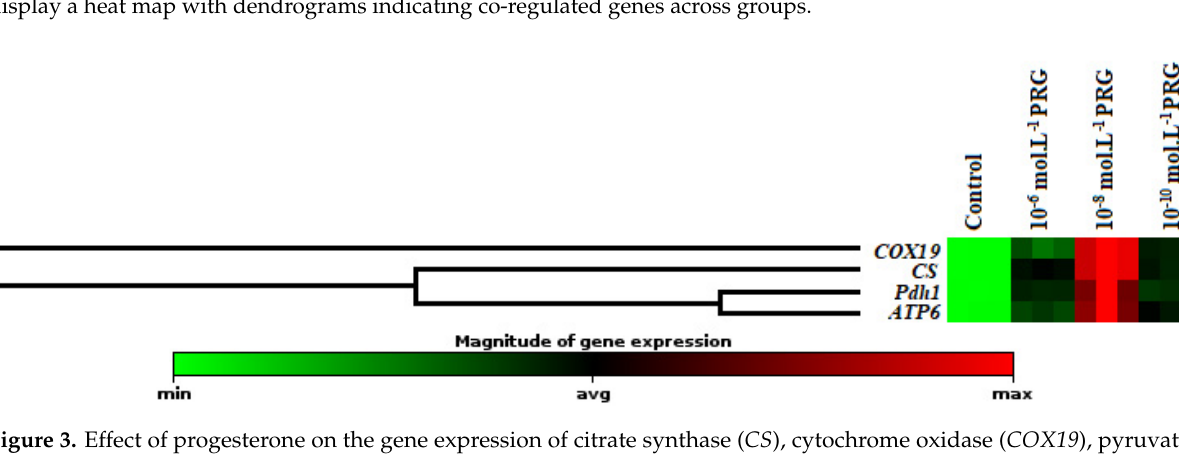
Figure 4. Effect of progesterone on the gene expression of citrate synthase ( CS ), cytochrome oxidase ( COX19 ), pyruvate dehydrogenase ( Pdh1 ), and ATP synthase ( ATP6 ) in the roots of 4-day-old maize seedlings. The clustergram performs non-supervised hierarchical clustering of the entire dataset to display a heat map with dendrograms indicating co-regu- lated genes across groups. 3. Discussion The present investigation aimed, for the first time, to reveal the effects of exogenous progesterone application on early seedling growth based on the changes in particularly mitochondrial respiration besides physiological ad biochemical parameters in germinat- ing maize seeds. All applied concentrations of progesterone significantly increased the root and coleoptile lengths of maize seedlings in comparison to their controls. The best ameliorative effect on these parameters was obtained at 10 − 8 mol·L − 1 progesterone-applied seedlings (Figure 1). Similar to our findings, in research carried on 7-day-old maize seed- lings, 10 − 8 mol·L − 1 progesterone application exhibited the most stimulating effect on the lengths of root and seedling under salt stress in wheat [6]. In another study, it was re- ported that exogenous progesterone applications increased root and shoot lengths in win- ter wheat [19]. External differentiation in plants is shaped by changes in the types and levels of proteins and carbohydrates found in internal tissues [20]. For this reason, changes in soluble protein and carbohydrate content are considered indicators of growth and de- velopment [21]. Especially, decreases in protein content affect plant growth negatively. We found that total soluble protein content was higher than those of control plants in the root, coleoptile, and endosperm tissues of progesterone-applied seedlings (Table 1). Con-